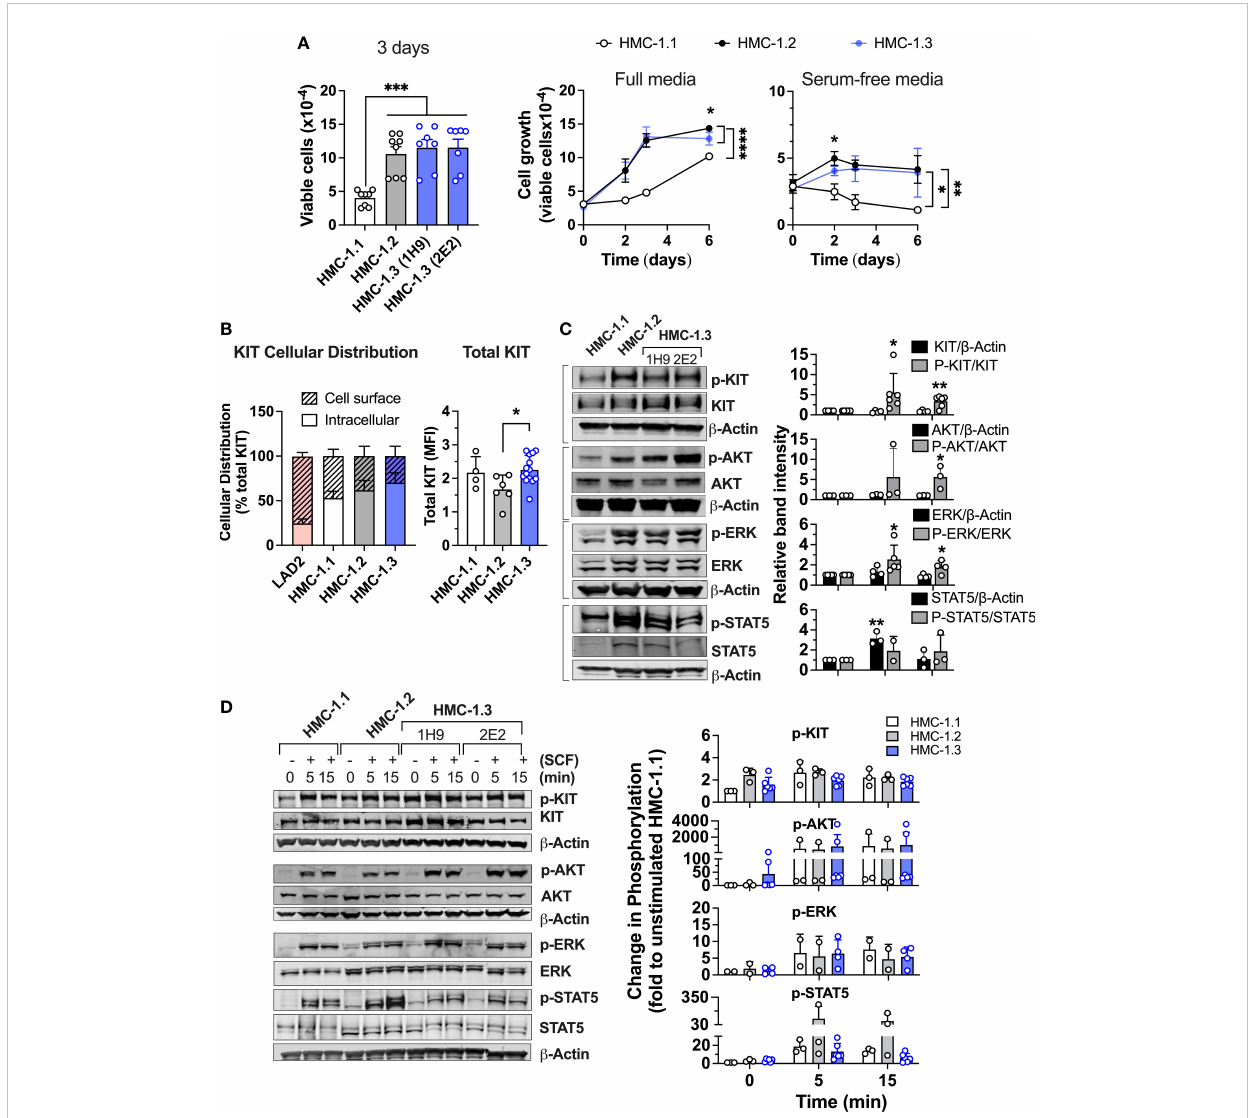
FIGURE 2 Comparison of cell growth, KIT expression and oncogenic KIT signaling in the various HMC-1 sublines. (A) Cell growth of HMC-1.1, HMC-1.2 and HMC-1.3 (1H9 and 2E2) in standard growing conditions after 72 h (bar graph; n ≥ 7 experiments; Mean ± SEM) and growth curves over time in full (middle panel) or serum-free media (right panel) (n ≥ 3 experiments; Mean ± SEM) showing HMC-1.3 as the average of both 1H9 and 2E2 subclones. *p<0.05; **p<0.01; ***p<0.001;****p<0.0001 using unpaired t-tests or when indicated with a bracket on the side of the curves, two-way ANOVA. Total cells were counted using a Celigo image cytometer and viable cells were calculated after subtraction of the number of dead cells determined by using PI staining. (B) Percent distribution (left) or total cellular expression (right) of KIT protein as determined by FACS analysis where data for HMC-1.3 is the average of both 1H9 and 2E2 subclones. Intracellular KIT was estimated from the difference between total and cell surface. *p<0.05 using an unpaired t-test. Shown is the Mean ± SD. (C) Western blot analysis showing constitutive phosphorylation of proteins in prominent oncogenic KIT signaling pathways in the indicated HMC-1 cell lines grown in normal culture conditions. Representative blots are on the left and quanti fi cations of the average relative band intensities are on the bar graphs on the right (Mean ± SD; n ≥ 3 independent experiments). Relative band intensities in each sample were corrected by the relative intensity of b -actin or total protein expression (as indicated) and expressed as fold change compared to HMC-1.1. *p<0.05; **p<0.01 using unpaired t-tests. (D) Western blot analysis showing phosphorylation changes induced by 100 ng/mL SCF for the indicated times. Cells were serum starved for 2 h before the addition of SCF. Representative blots are on the left and quanti fi cations of the average changes in relative band intensities are on the right (Mean ± SD of 2 to 3 independent experiments). Relative band intensities in each sample were normalized to the relative intensity of b -actin and expressed as fold change compared to HMC-1.1. Full scans of blots shown in (C, D) are shown in Supplementary Figures 8, 9,